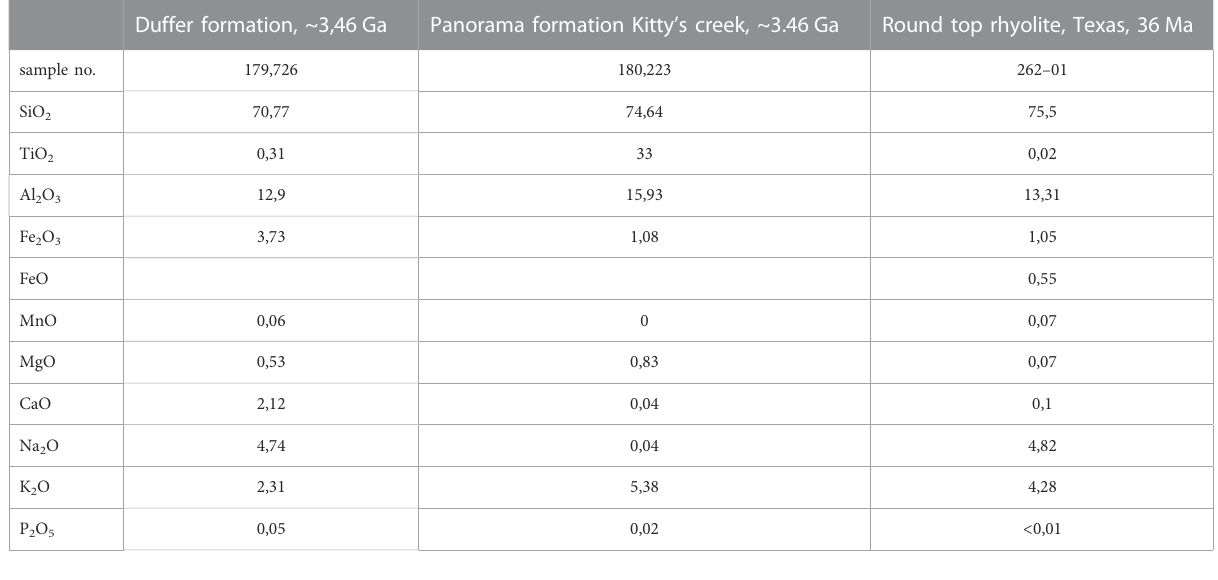
TABLE 4 Compositions of felsic lavas from the 3.46 Ga Duffer Formation and Panorama Formation at Kitty ’ s Creek (Smithies et al., 2007), compared to recent (36 Ma) rhyolites from Texas (Elliott, 2018). The Palaeaoarchaean rhyolites are enriched in Fe and Mg and are poor in K, compared to the younger rhyolites. Duffer formation, ~3,46 Ga Panorama formation Kitty ’ s creek, ~3.46 Ga Round top rhyolite, Texas, 36 Ma sample no.